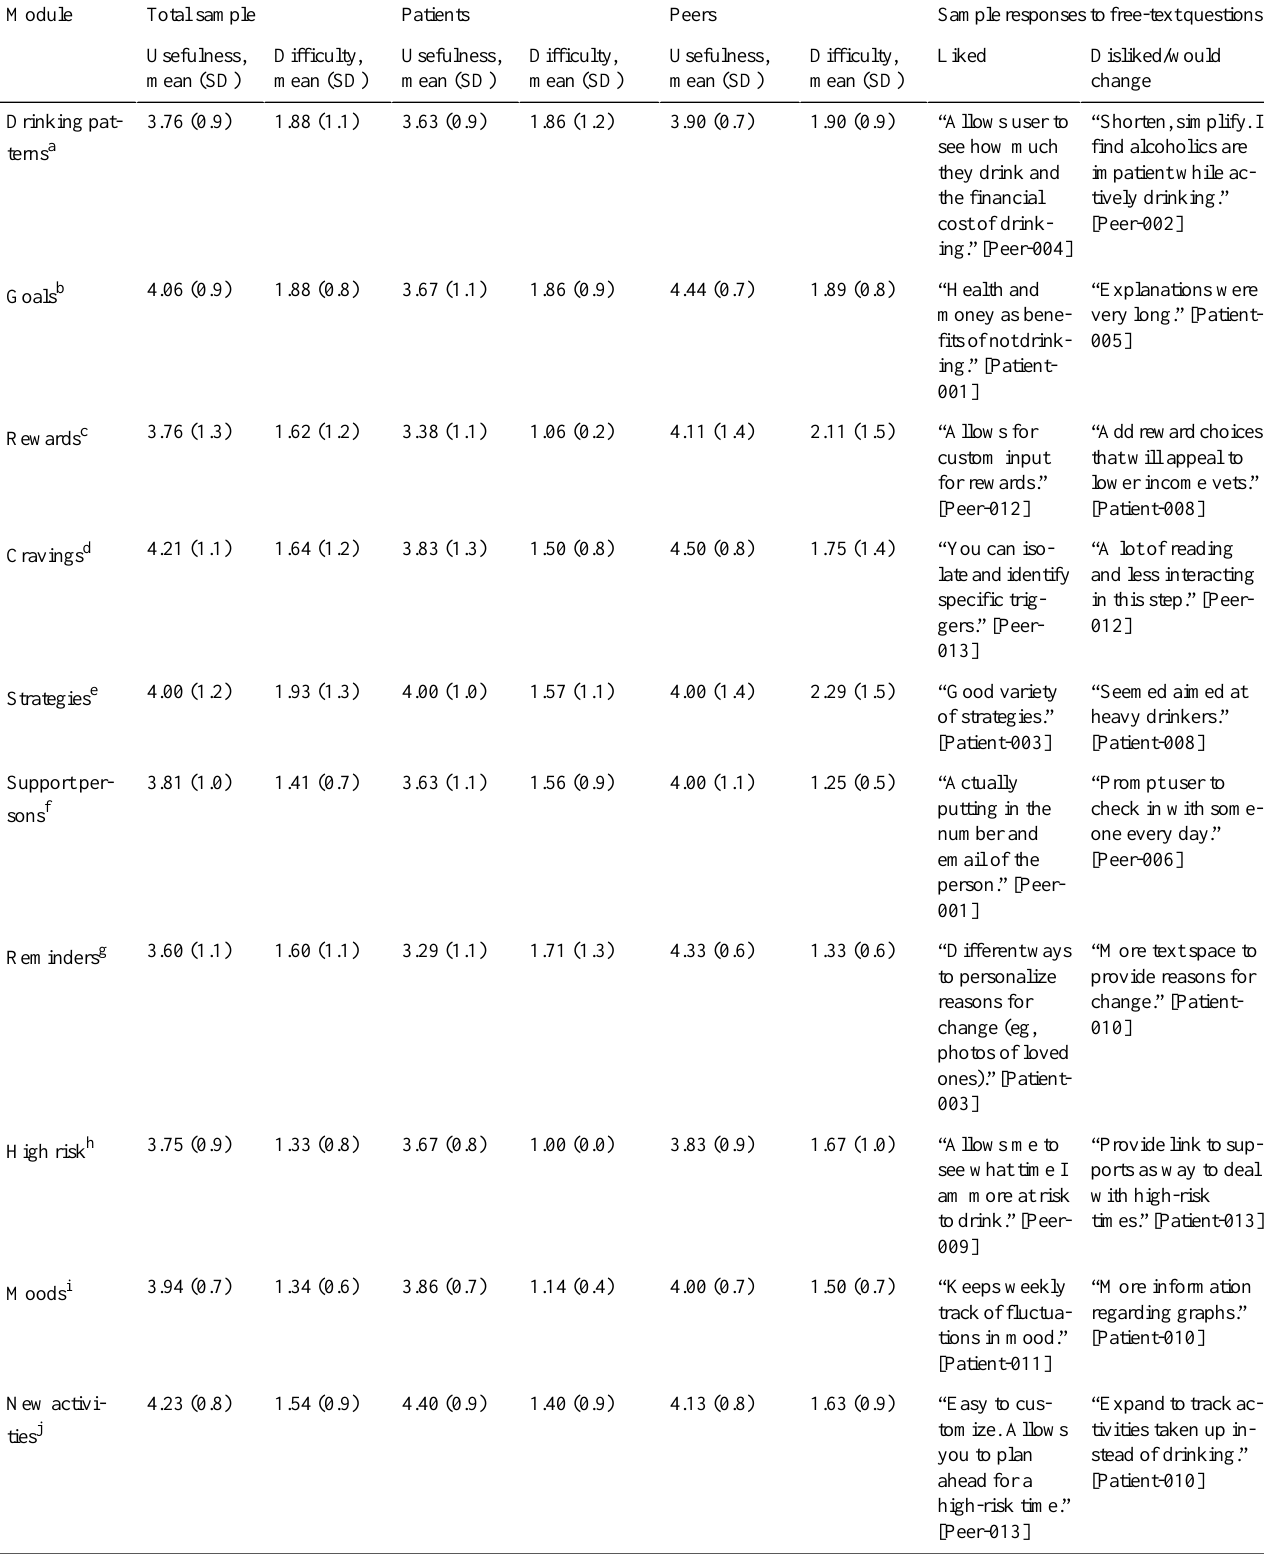
Table 2. Usability ratings of the Step Away modules from veteran patients and peer providers.